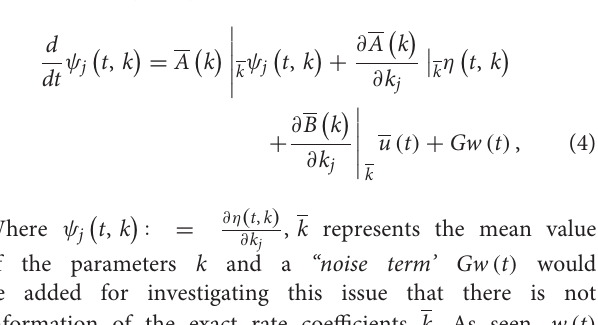
stand for the input and output stoichiometric coefficients that indicate the numbers of units of every item entering j − th step of the process. Moreover, the flow rate constants of k j , j = 1, ..., r , stand for the parameters characterizing the underlined process’s storage capacity and flow constraints (For more information see Appendix A